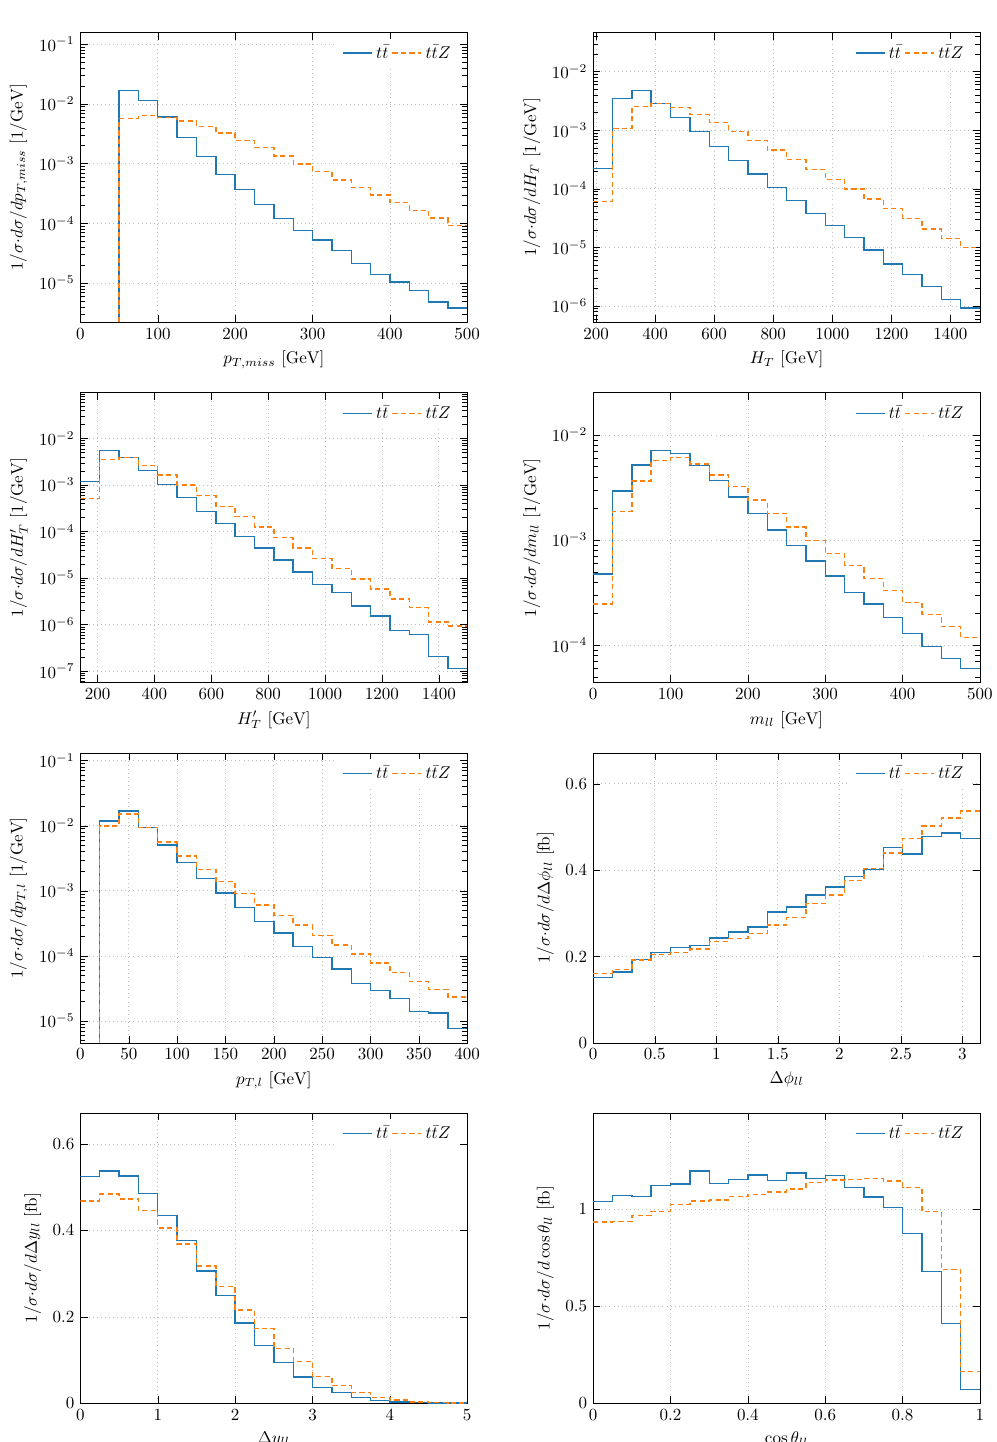
Figure 14 . Comparison of the normalised NLO di(cid:11)erential cross sections for pp and pp e + (cid:23) e (cid:22) (cid:0) (cid:22) (cid:23) (cid:22) b (cid:22) b (cid:23) (cid:28) (cid:22) (cid:23) (cid:28) + X at the LHC with p s = 13 TeV. The following distributions are ! shown: p miss , H T , H 0 , m ‘‘ , (averaged) p T;‘ , (cid:1) (cid:30) ‘‘ , (cid:1) y ‘‘ and cos (cid:18) ‘‘ . The NLO CT14 PDF set is T T employed and the scale choices (cid:22) 0 = H T = 3 ( t (cid:22) tZ ) and (cid:22) 0 = H T = 4 ( t (cid:22) t ) are utilised.